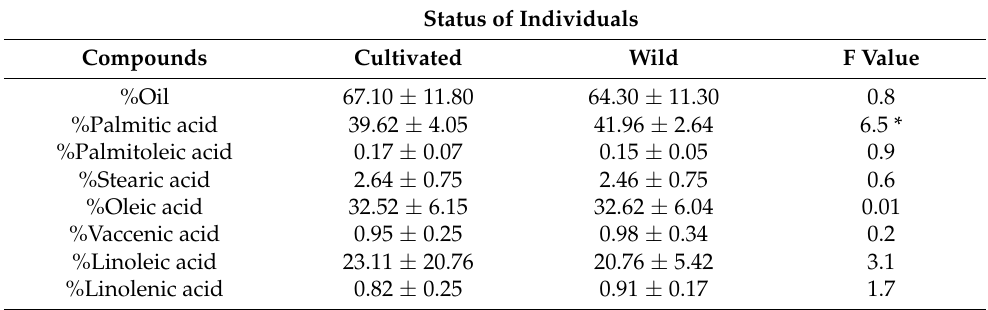
Figure 6. Distribution of the mesocarp oil content and fatty acid composition in cultivated (red lines) and wild (green lines) D. edulis individuals. Table 4 . Fruit mesocarp total oil content and fatty acid composition in cultivated and wild D. edulis .